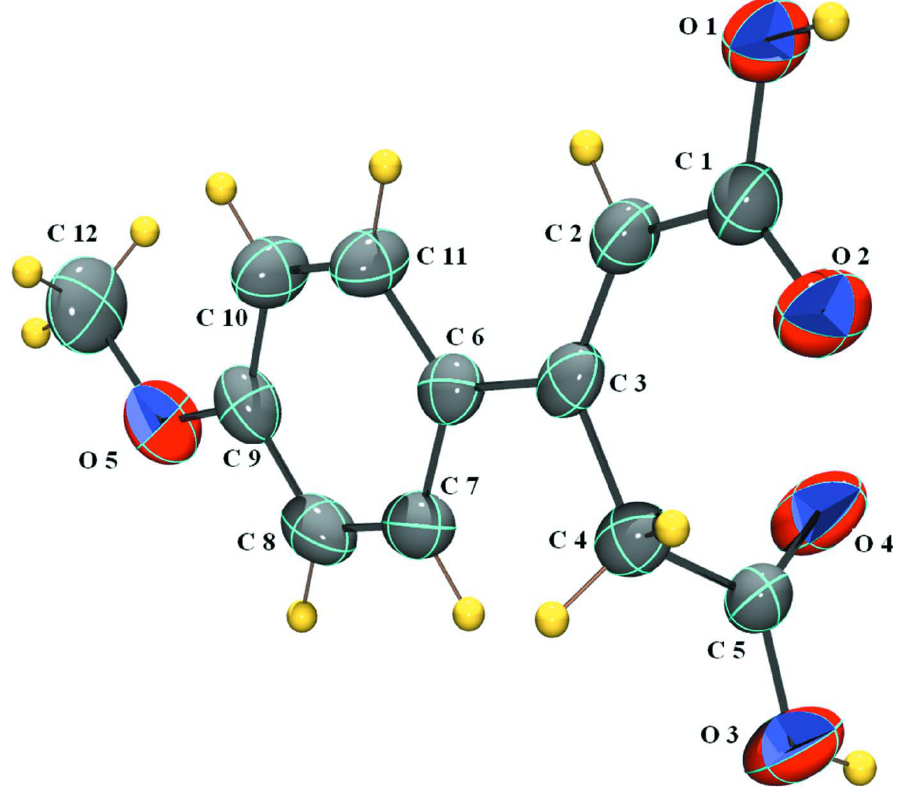
View of the molecular structure of (I) with displacement ellipsoids drawn at the 50% probability level. H atoms are shown as small spheres of arbitrary